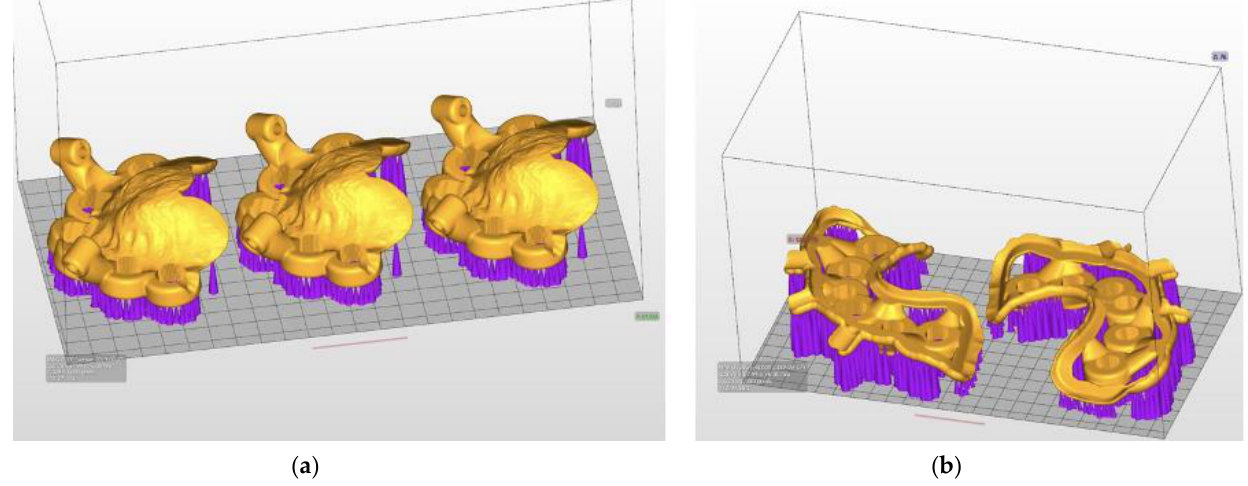
Figure 3. STL reference images in ASIGA MAX UV slicing software containing implant surgical guides with support structures in place. ( a ) Upper; ( b )